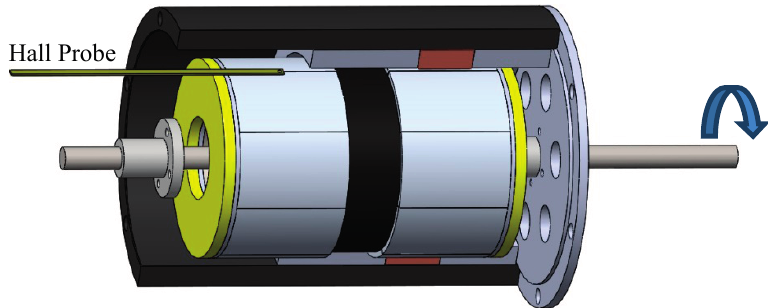
and tangential B components r t